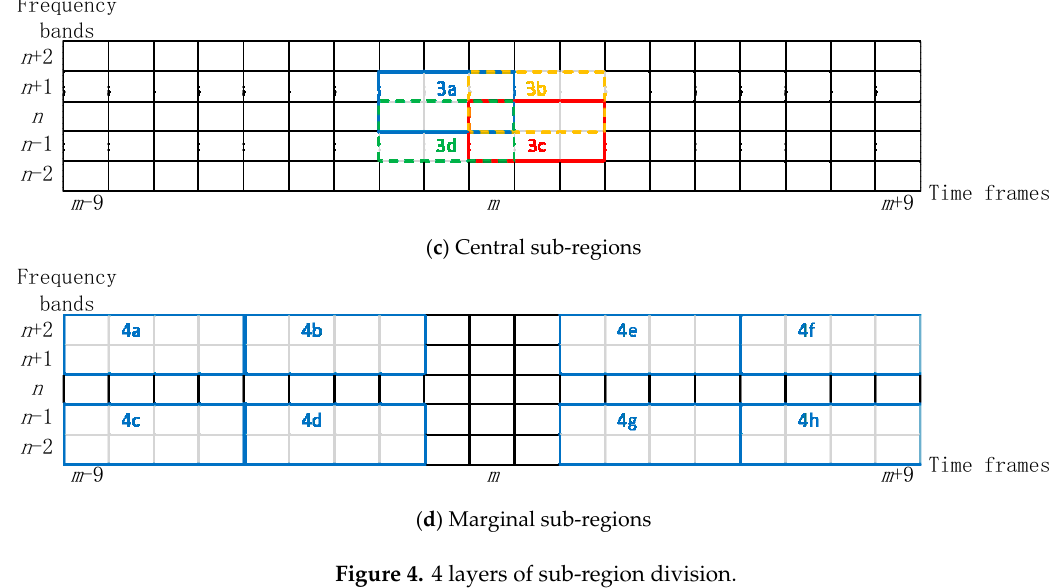
Figure 4. 4 layers of sub-region division.